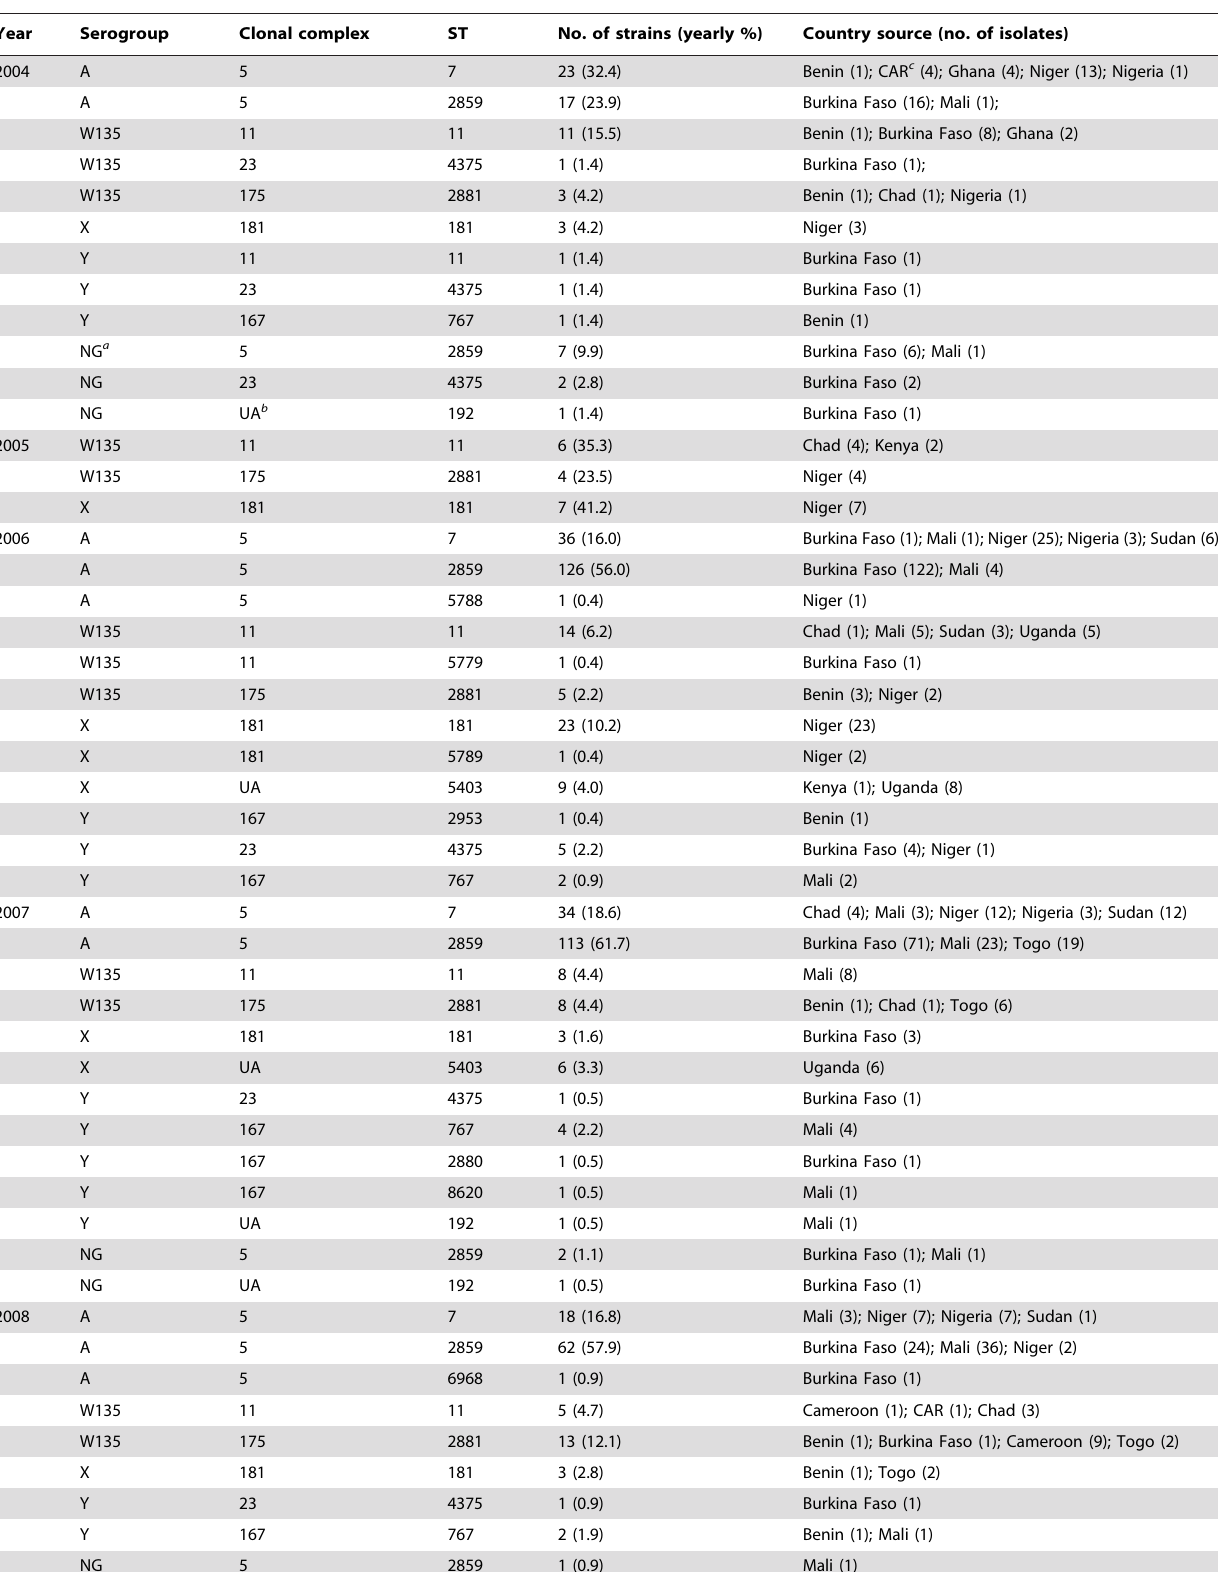
Table 1. Serogroup and sequence type (ST) of invasive meningococcal isolates from sub-Saharan Africa in 2004–2010.